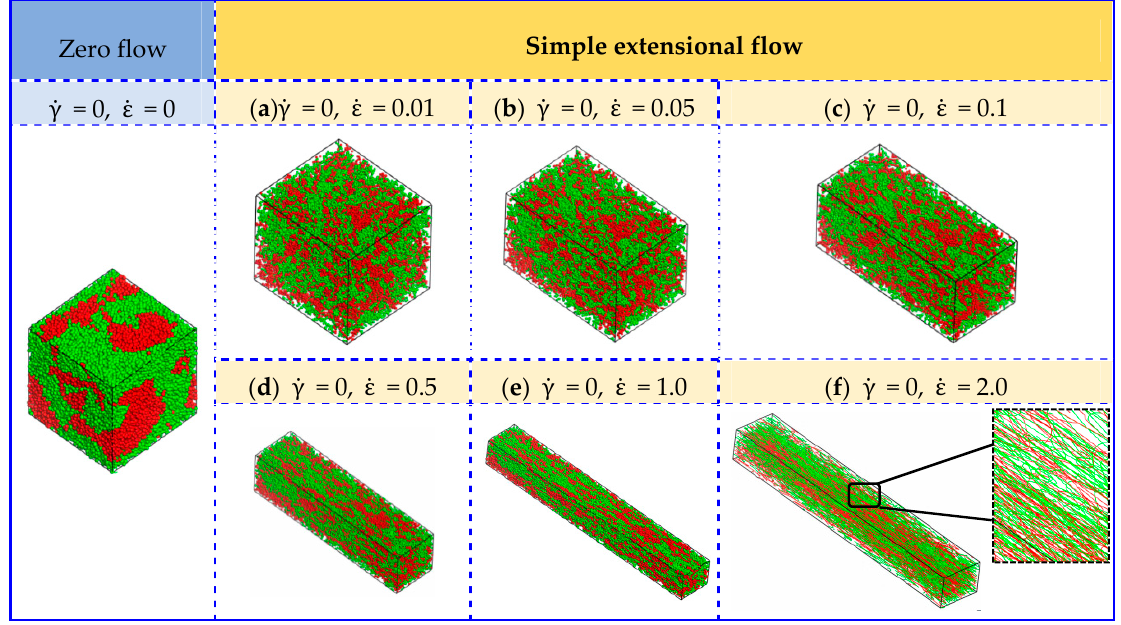
Figure 3. Conformationof UHMWPE/PA6 blends at 50/50 mass fractions under different extensional rates. The red and blue beads represent the PA6 and UHMWPE polymers, respectively. ( f ) is displayed in line style and the others are presented in dot-line style.